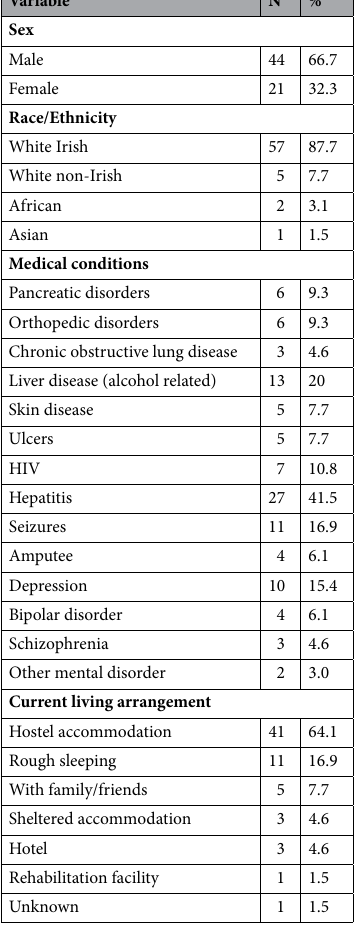
Parameter All participants N Male participants n Female participants n P value Short Physical Performance Battery, median(IQR) 5(2–8) Timed Up and Go, s, mean (SD) 22.39 (20.2) Six Minute Walk Test, m, mean (SD) 289.9 (113.3)